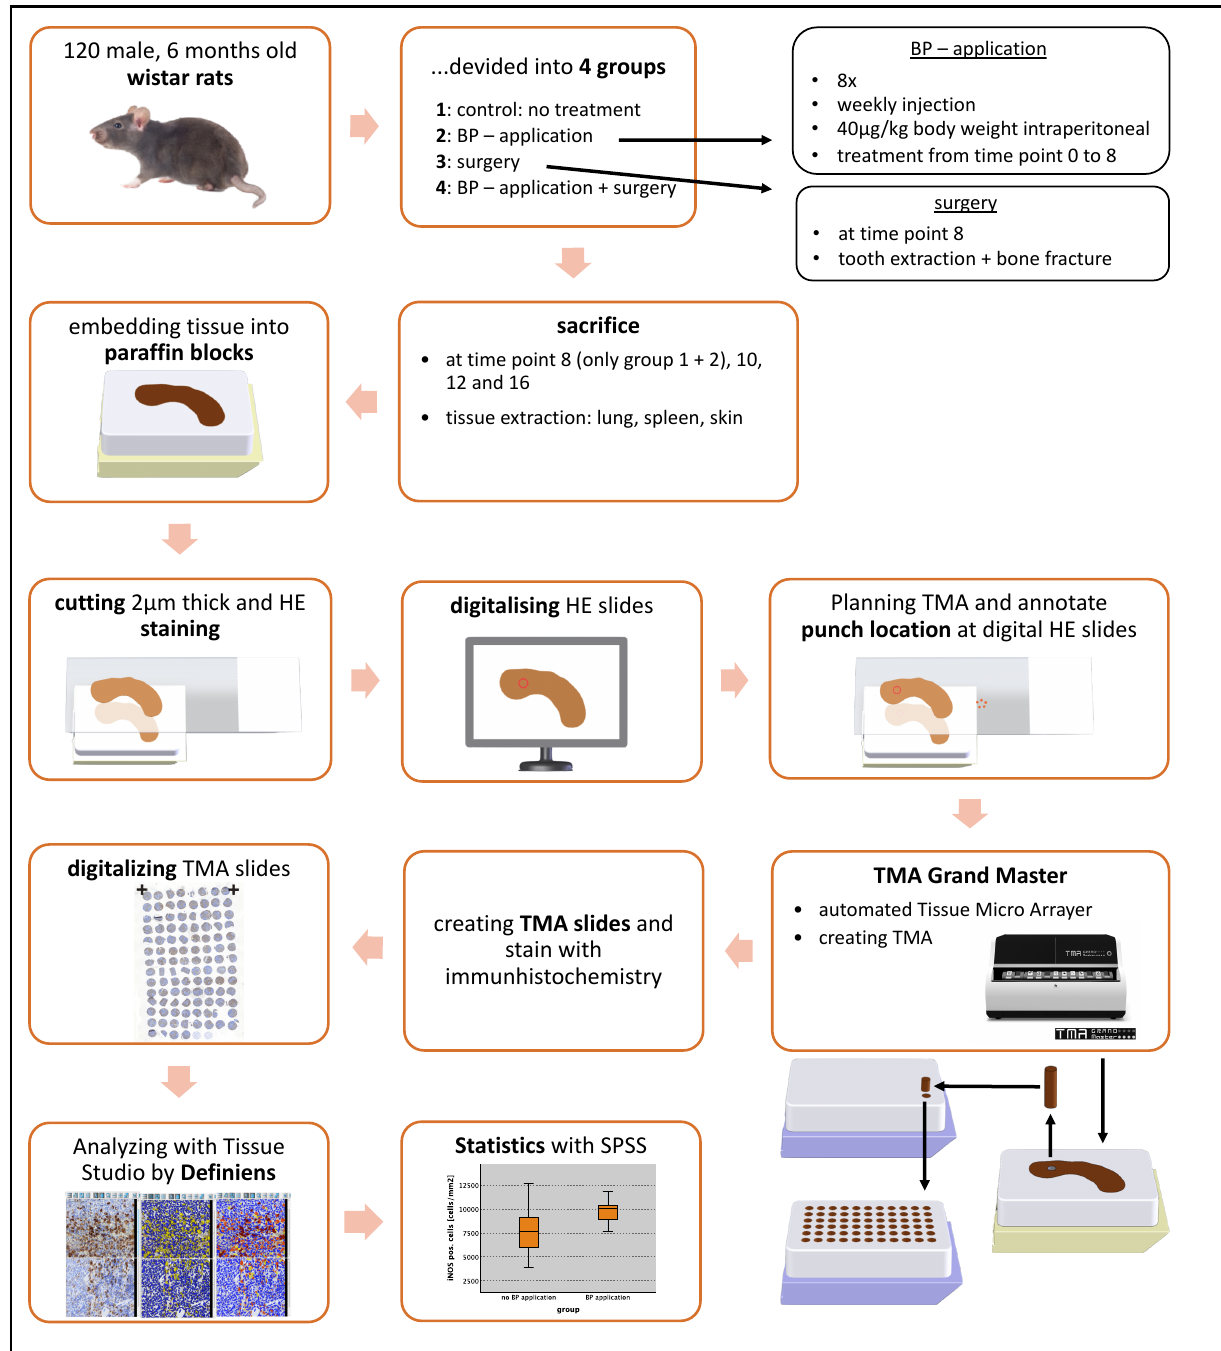
Figure 4. Experimental layout. Overview and visualization of the individual steps performed in this experiment. 3D sketches with kind permission of W.